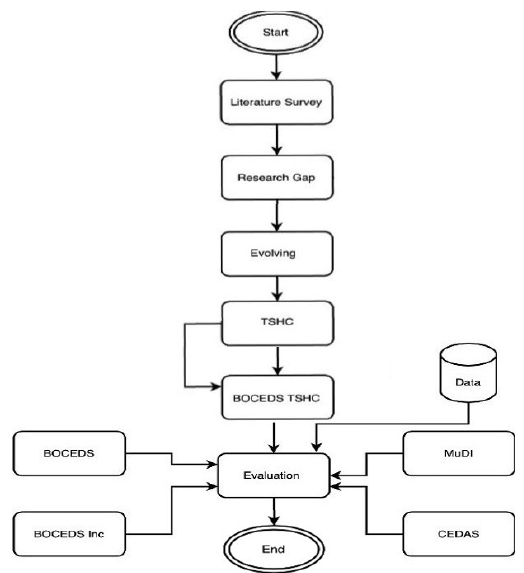
Figure 1. Flowchart of the Developed Methodology.